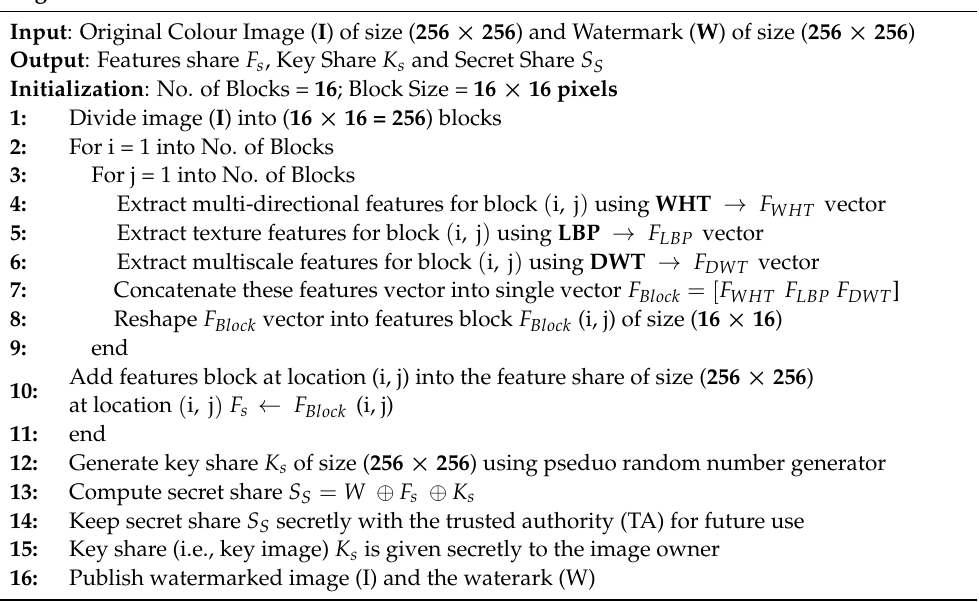
Algorithm 1: Shares Construction